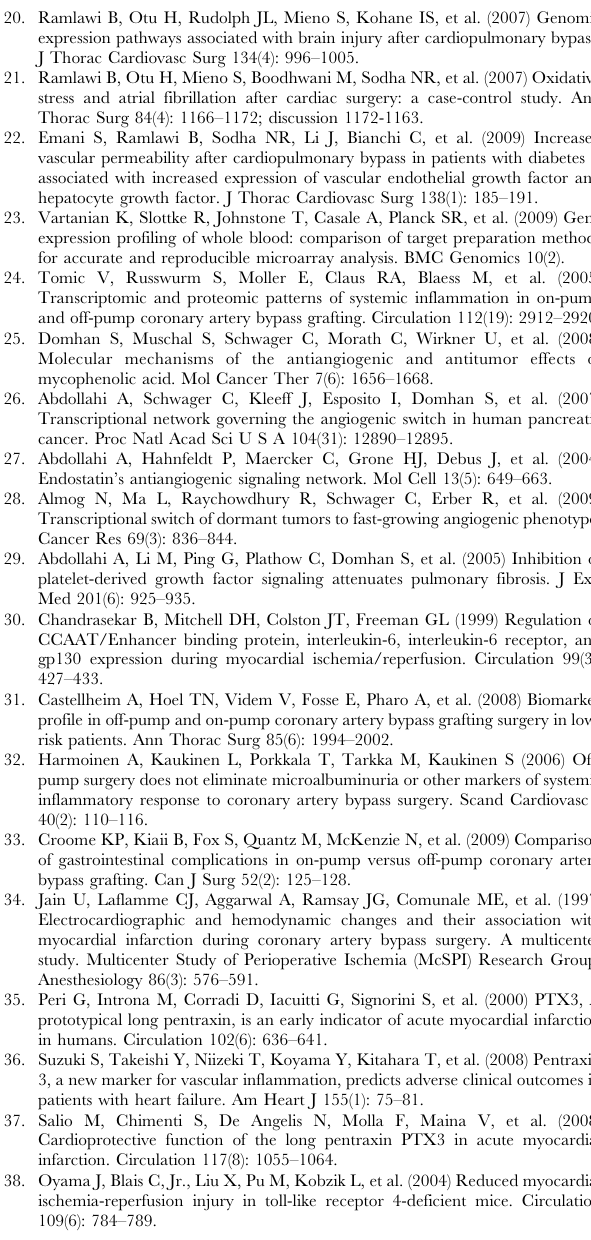
Found at: doi:10.1371/journal.pone.0013658.s001 (0.87 MB